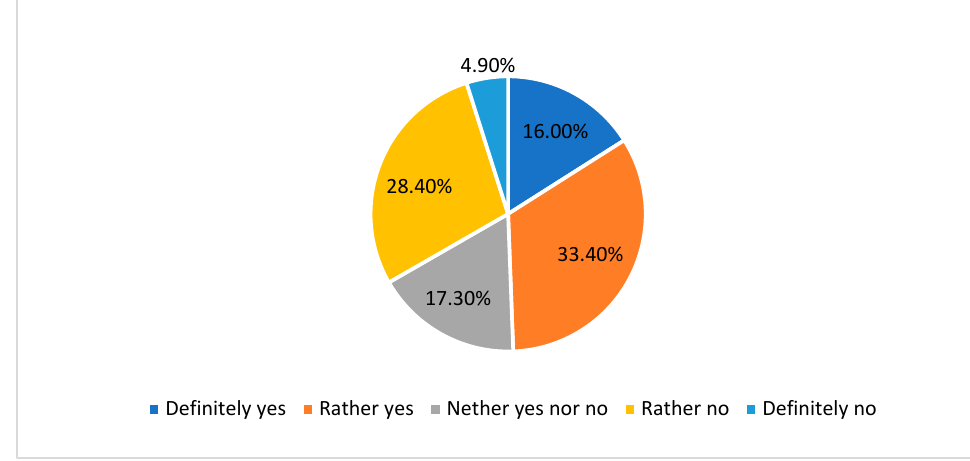
Figure 13. Tourists’ sensitivities to air quality in visited places. Source: own study.